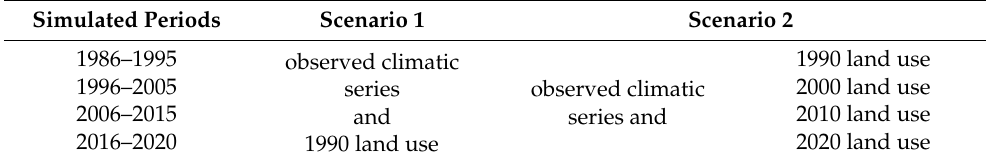
Table 3. Scenario